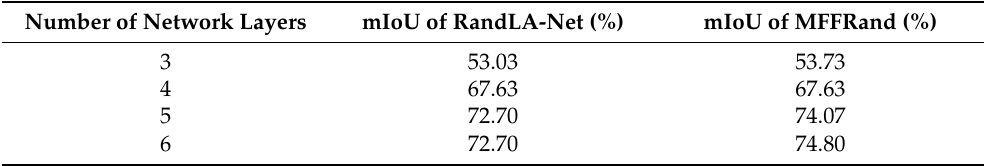
Table 5. Influence of the number of network layers on inference